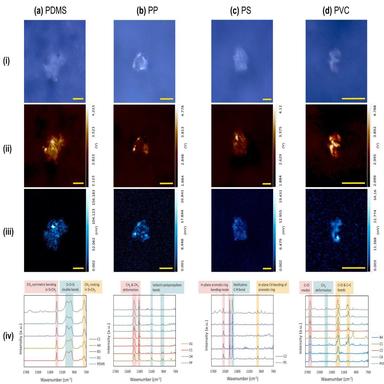
The identification of MPs originated from the IV delivery system. The MP-types derived from various constituents of the IV system are organized in a columnar format, including (a) PDMS, (b) PP, (c) PS, and (d) PVC. The rows of the figure display different categories of data, (i) Optical images, (ii) Visible-Laser images, (iii) O-PTIR images of representative MPs on Anodisc filter membranes, and (iv) normalized O-PTIR spectra of detected MPs (For PDMS, representative spectra from each of the 4 sample sets ar